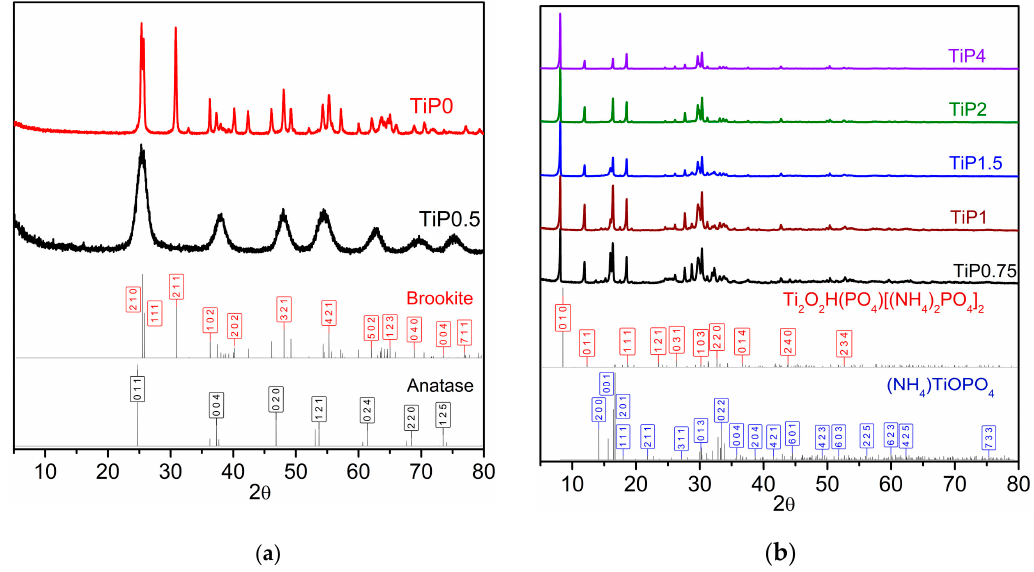
Figure 1. Powder X-ray diffraction patterns for the samples prepared by hydrothermal treatment of titanium lactate at 180 °C in the presence of urea with different concentrations of phosphate ions; ( a ) XRD patterns of TiP0 and TiP0.5 contain only brookite and anatase respectively, ( b ) XRD patterns of TiP0.75-TiP4 contain mixture of Ti 2 O 2 H(PO 4 )[(NH 4 ) 2 PO 4 ] 2 and (NH 4 )TiOPO 4 .